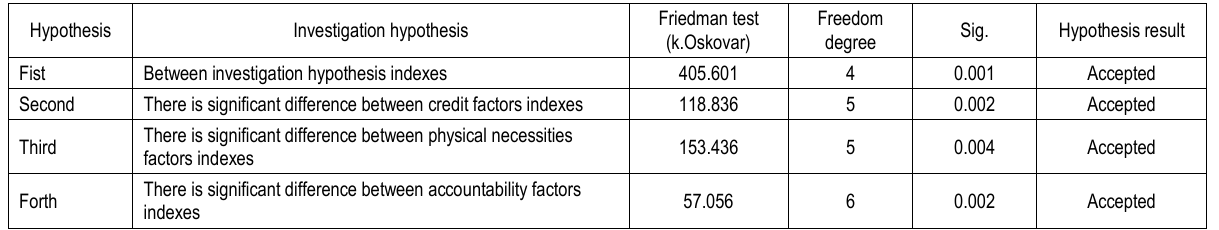
Table 22. Results of significance between hypothesis and each of investigation